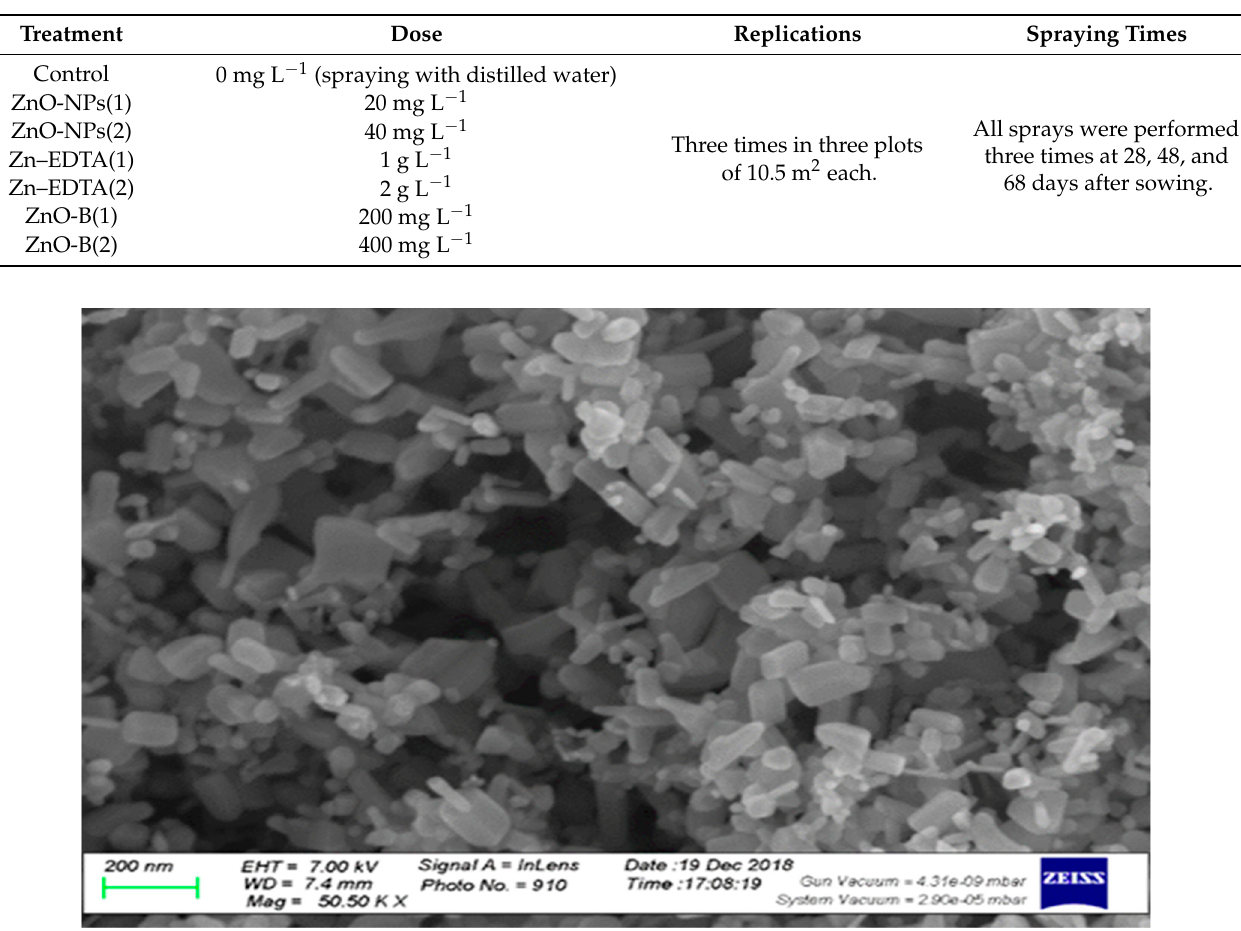
Figure 1. TEM image of zinc oxide nanoparticles (ZnO-NPs) (cited from Awad et al. [17]). The area assigned to the experiments was divided into 21 plots (3.0 m × 3.5 m = 10.5 m 2